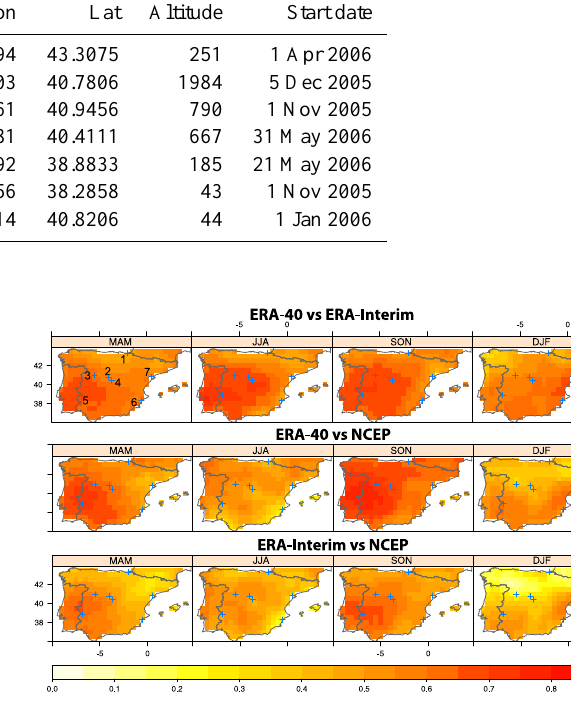
Fig. 1. Correlations (Mann-Kendall’s Tau coefficient) between the daily FWI values calculated upon the different reanalyses consider- ing their overlapping time period (1989–2001). All grid points are significant at the α = 0 . 05 significance level. Crosses indicate the locations of the control weather stations, which have been labeled in the upper left hand panel according to numeric codes displayed in Table